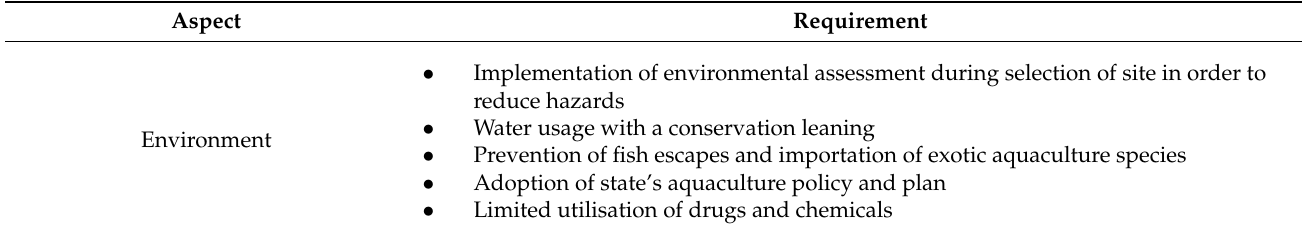
Table 2. Mitigation guideline for sustainability